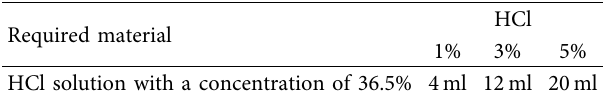
Table 3: Concentrated hydrochloric acid required for the prepa- ration of different concentrations of HCl solution.